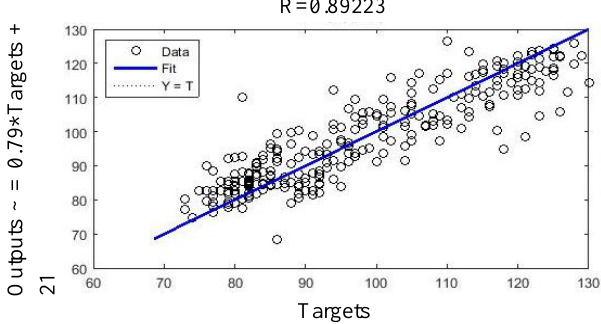
Fig. 10. Correlation between the targets and outputs for GMDH